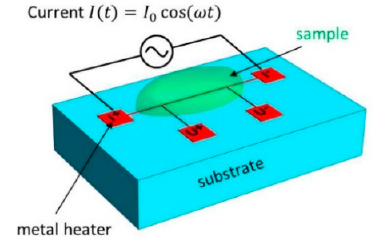
Figure 1. Schematic of the extended 3 ω method.